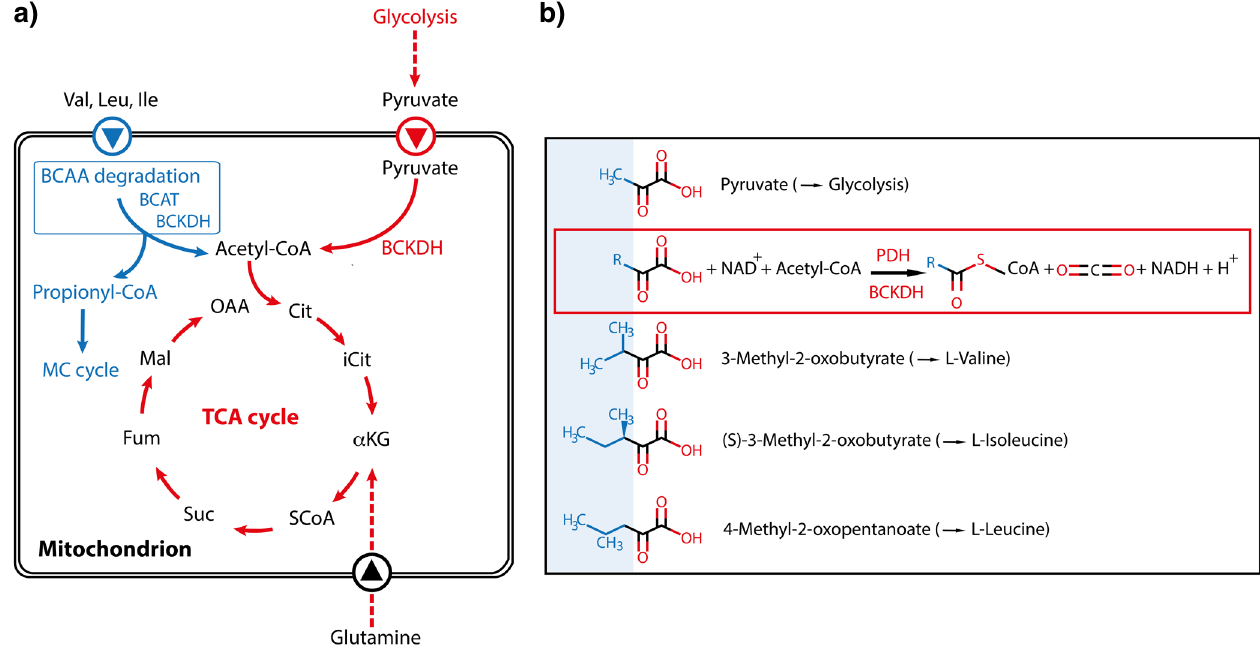
Figure 3. Feeding of the mitochondrial carbon metabolism. a) Current model of how the tricarboxylic acid (TCA) cycle is fed with substrates in both Toxoplasma gondii (blue) and Plasmodium berghei (red; in common with T. gondii ) and converted to acetyl-CoA. The latter then enters the TCA cycle. BCAA degradation in T. gondii can lead to toxic propionyl-CoA, which could be detoxified by the 2-methylcitrate (MC) cycle. Its physiological importance for the different T. gondii stages is currently ill defined, as both BCAA degradation and MC cycle are dispensable in tachyzoites 131 . Abbreviations: α -KG, α -ketoglutarate; BCAT, branched-chain amino acid transferase; BCKDH, branched-chain keto acid dehydrogenase; Fum, fumarate; Cit, citrate; iCit, isocitrate; Mal, malate; OAA, oxaloacetic acid; PEP, phosphoenolpyruvate; Suc, succinate. Figure adapted and redrawn from 51. b) Structural similarities of substrates for pyruvate dehydrogenase (PDH) and branched-chain keto acid dehydrogenase (BCKDH), respectively. The framed reaction scheme illustrates the overall generation of CoA compounds and CO substrates catalyzed by the two